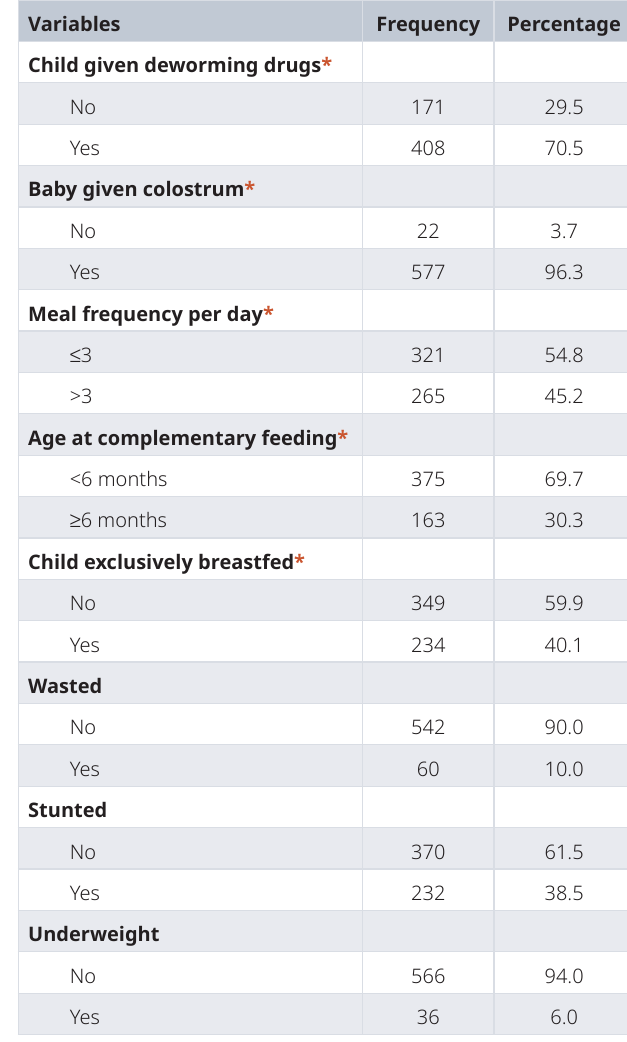
Table 2. Nutritional characteristics